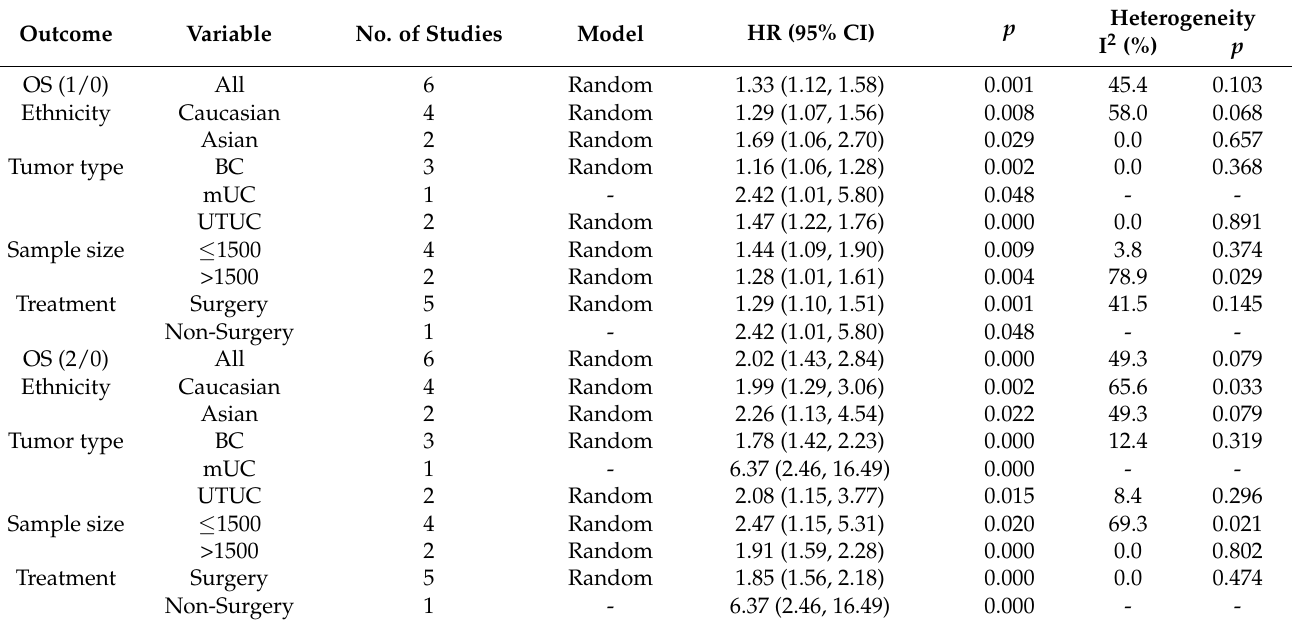
Table 3. Subgroup analyses of